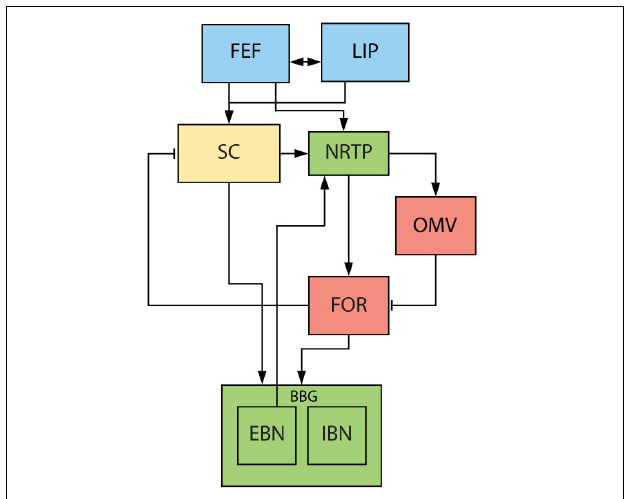
FIGURE 2 | Overview of saccade related areas in the midbrain, brainstem, and cerebellum. Saccade targets are jointly selected by cerebral cortex (blue) and SC (yellow). Subsequently, SC, brainstem (green) and cerebellum (red) execute the movement. SC provides drive to premotor nuclei and cerebellum via NRTP. Cerebellum provides additional drive to premotor nuclei through the FOR. EBN give feedback signal back to cerebellum about the progress of the saccade. FEF, frontal eye fields. LIP, lateral intraparietal cortex. SC, superior colliculus. NRTP, nucleus reticularis tegmenti pontis. OMV, oculomotor vermis. FOR, fastigial oculomotor region. EBN, excitatory burst neurons. IBN, inhibitory burst neurons. Blue areas are in the cerebral cortex, yellow areas represent the midbrain, green areas the brainstem, and red areas part of the